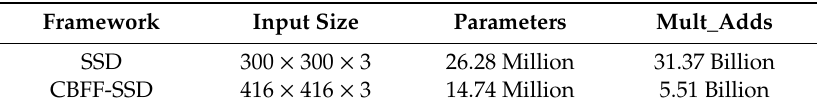
Figure 1. The overall structure of the proposed context-based feature fusion single shot multi-box detector (CBFF-SSD) algorithm framework. Table 1. Comparison of the number of parameters and calculation amount of the SSD and the proposed CBFF-SSD framework.